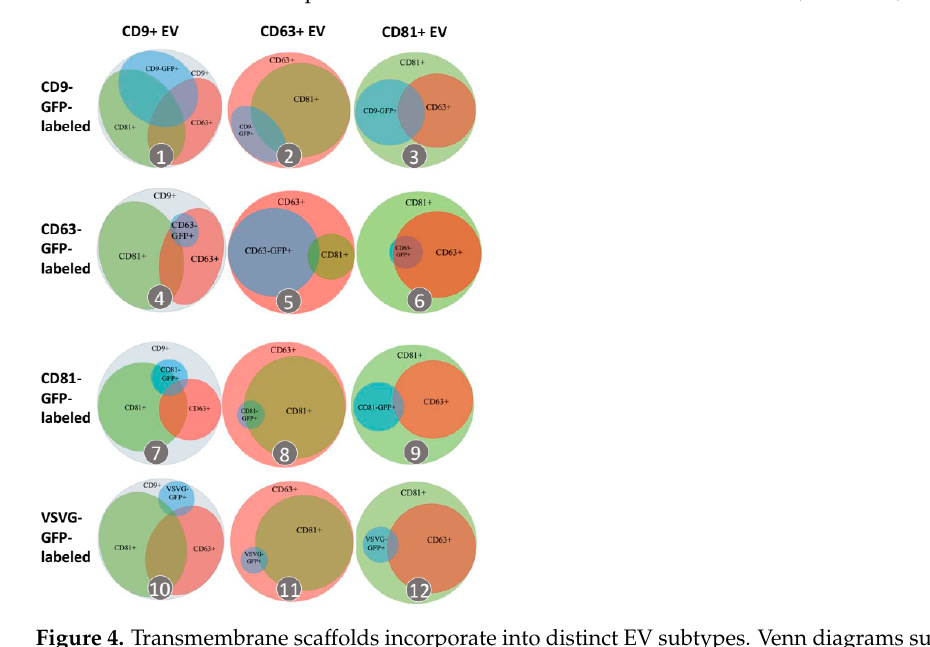
Figure 3. On-chip analysis of antibody-captured EVs. ( A ) A schematic representation of on-chip analysis of genetically labeled EVs. The size of EVs was measured and calculated using signals from the interference of light (interferometry). Surface marker profiles of EVs were specifically detected by fluorescein-labeled monoclonal antibodies. ( B – E ) Molecular profiling of various EV subtypes and subpopulations of scaffold-modified EVs. ( B1 – B5 ) CD9-GFP-modified EVs captured by anti- CD81-GFP-modified EVs captured by anti-CD81 antibodies. ( E16 – E20 ) VSVG-GFP-modified EVs captured by anti-CD81 antibodies. A portion of the spots ( B1 , C6 , D11 , E16 ) was magnified to show the individual EVs and expression/co-expression of the surface markers, CD9/CD63/CD81/scaffold- GFP. Arrows indicate co-expression of surface markers on individual vesicles; Scale bar, 10 µ m.